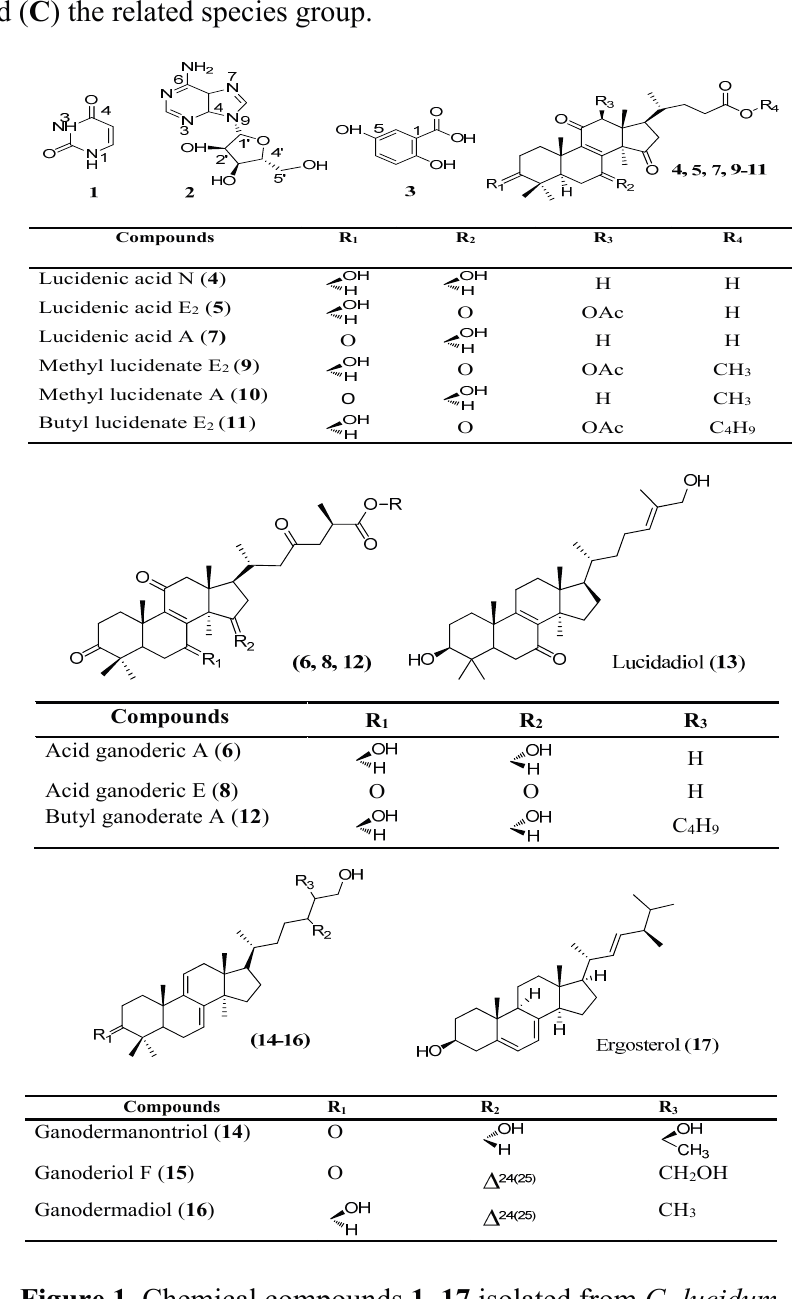
Figure 1. Chemical compounds 1 – 17 isolated from G. lucidum